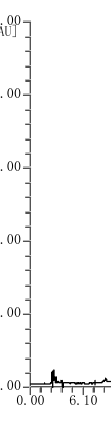
Figure 3. HPLC chromatograms of the mulberry extracts.